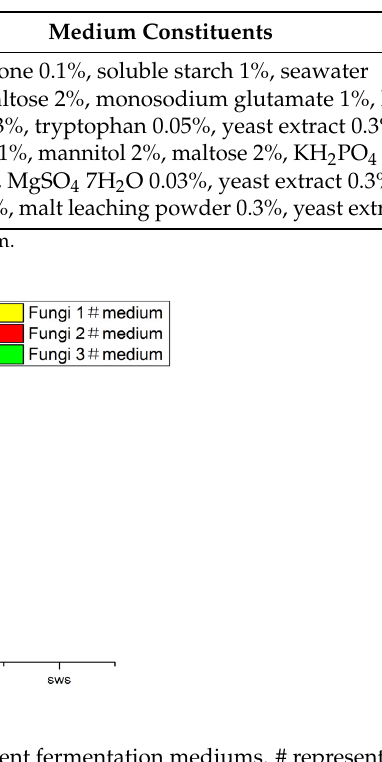
Table 3. Culture medium constituents.